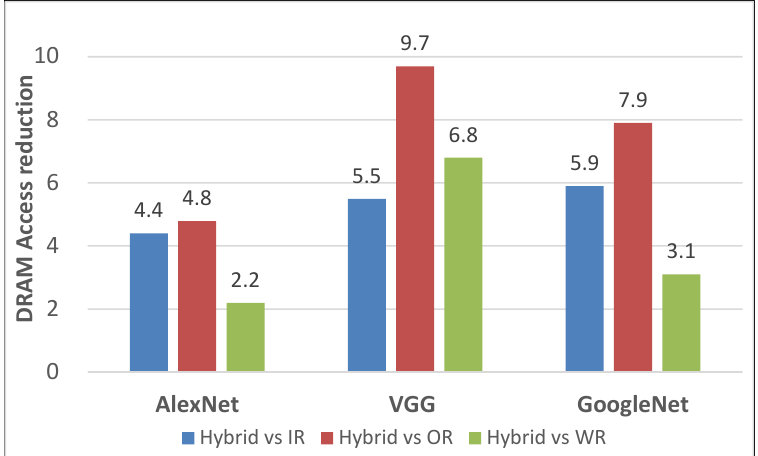
Figure 14. The memory access reduction: hybrid mode over single mode